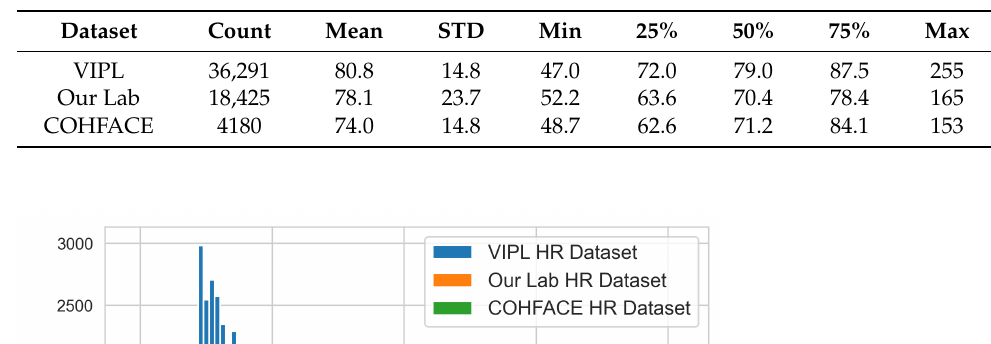
Table 1. Statistical Summary of the HR Engineered Datasets Based on the Extracted Green-Channel Data.